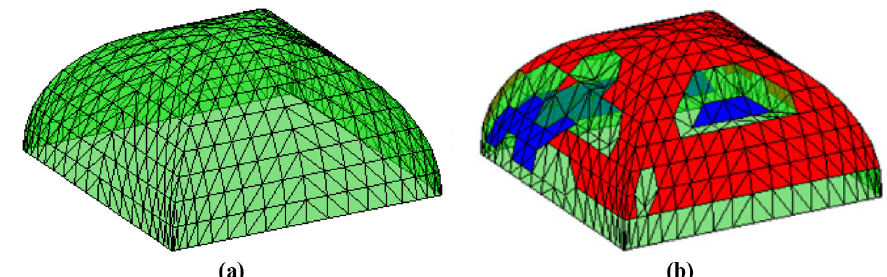
Figure 3. Load condition of the cloister vault